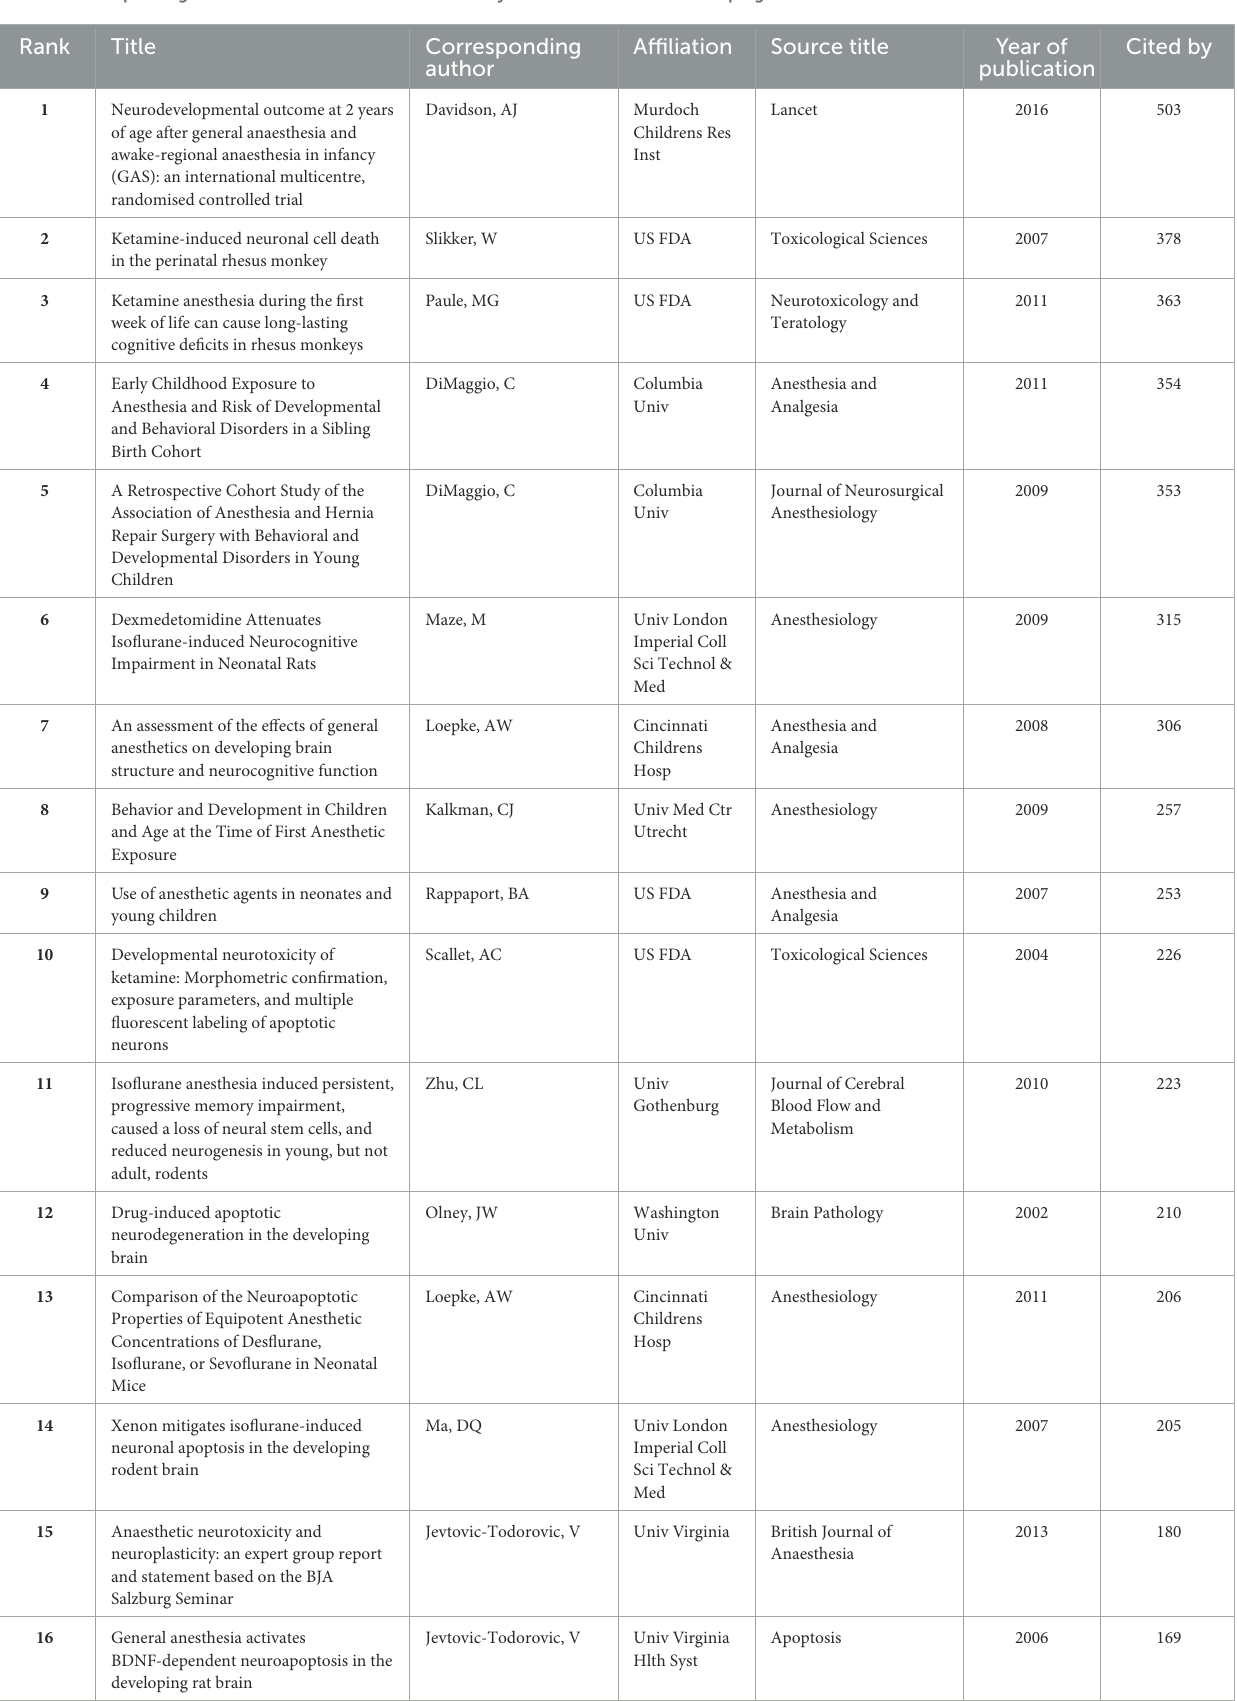
TABLE 6 The top 20 highest-cited articles on the neurotoxicity of anesthesia in the developing brain.